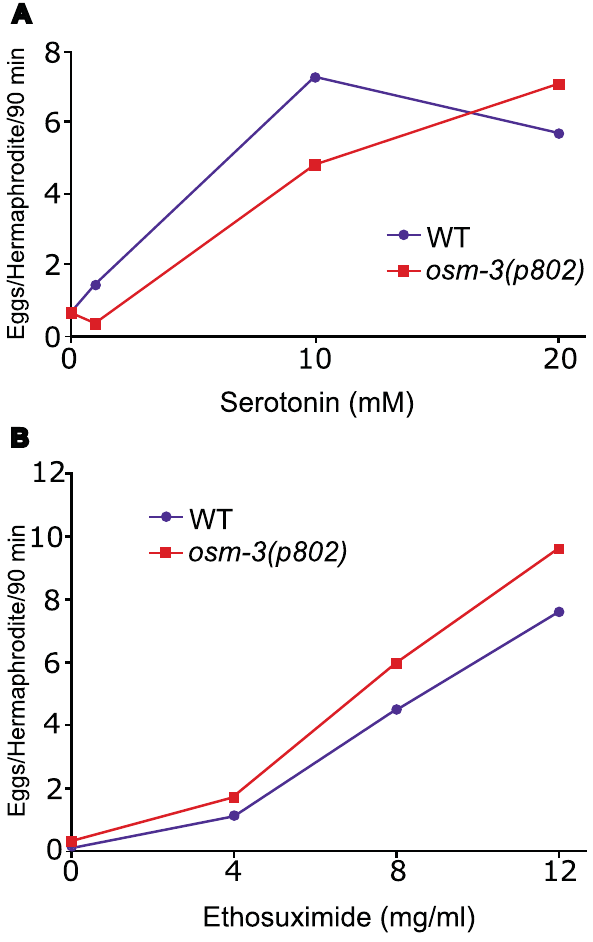
Figure 5. osm-3(p802) animals are sensitive to egg-laying stimulated by serotonin and ethosuximide. (A) Gravid hermaph- rodites were placed individually in M9 buffer containing the indicated serotonin concentration, and the number of eggs laid in 90 minutes was scored. The mean number of eggs laid 6 SD by wild-type animals (blue circles) was 0.6 6 1.2, 1.4 6 1.8, 7.3 6 4.9, and 5.7 6 4.3 for serotonin concentrations of 0, 1, 10, and 20 mM, respectively. The mean number of eggs laid 6 SD by osm-3(p802) animals (red squares) was 0.6 6 1.7, 0.3 6 0.9, 4.8 6 3.5, and 7.1 6 3.4 for serotonin concentrations of 0, 1, 10, and 20 mM, respectively. N . 11 for all trials. At all serotonin concentrations, differences in egg-laying between WT and osm-3 were not statistically significant, p . 0.05 (Student t-test). (B) Experiments with ethosuximide were carried out as above with the indicated concentra- tion of ethosuximide. The mean number of eggs laid 6 SD by wild-type animals (blue circles) was 0.2 6 0.5, 1.1 6 1.4, 4.5 6 4.2, and 7.6 6 3.6 for ethosuximide concentrations of 0, 4, 8, and 12 mg/ml, respectively. The mean number of eggs laid 6 SD by osm-3 mutant animals (red squares) was 0.3 6 0.8, 1.7 6 2.6, 6.0 6 4.3, and 9.6 6 2.8 for ethosuximide concen- trations of 0, 4, 8, and 12 mg/ml, respectively. n=24 for all trials. Differences in egg-laying between WT and osm-3 at ethosuximide concentrations of 0, 4, and 8 were not statistically significant, p . 0.05 (Student T-test). At 12 mg/ml ethosuximide, osm-3 animals laid significantly more eggs than wild-type animals, p=0.03 (Student T-test).